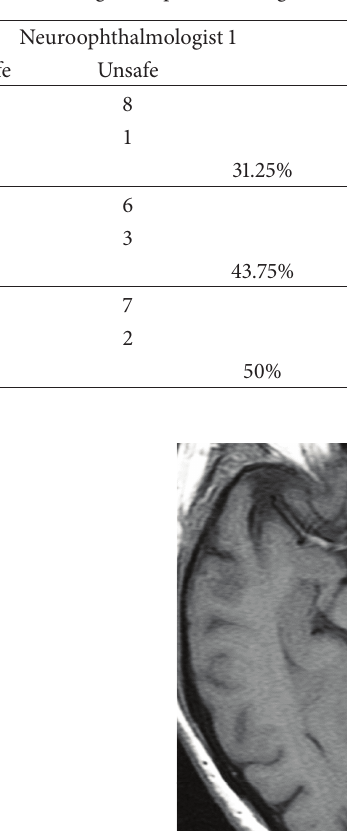
Table 3: The ability of the two neuroophthalmologists to predict a range of driving outcomes.